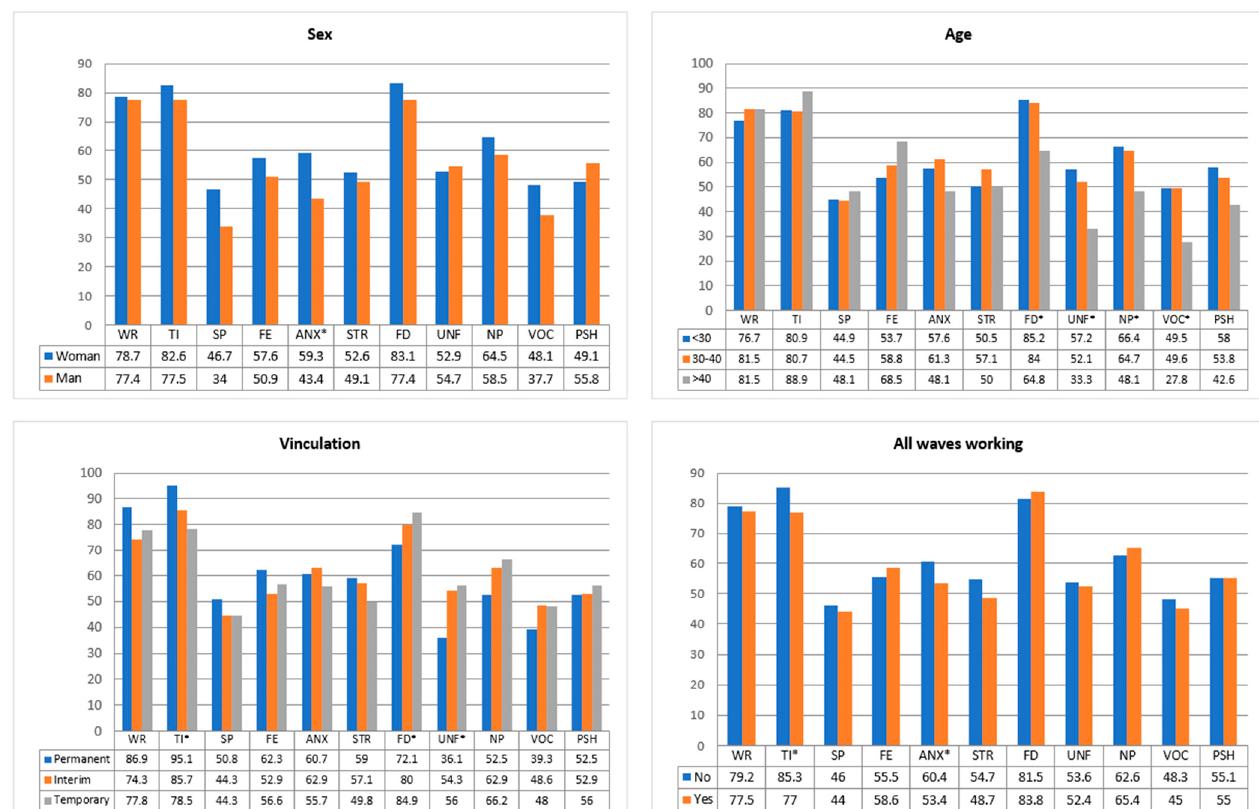
Figure 1. Association between psychological variables and nurses’ characteristics. WR (worried), TI (tired), SP (sleep problems), FE (fear), ANX (anxiety), STR (stress), FD (felt down), UNF (unfocused), NP (negative performance), VOC (vocation), PSH (psychological kelp); * significant value.